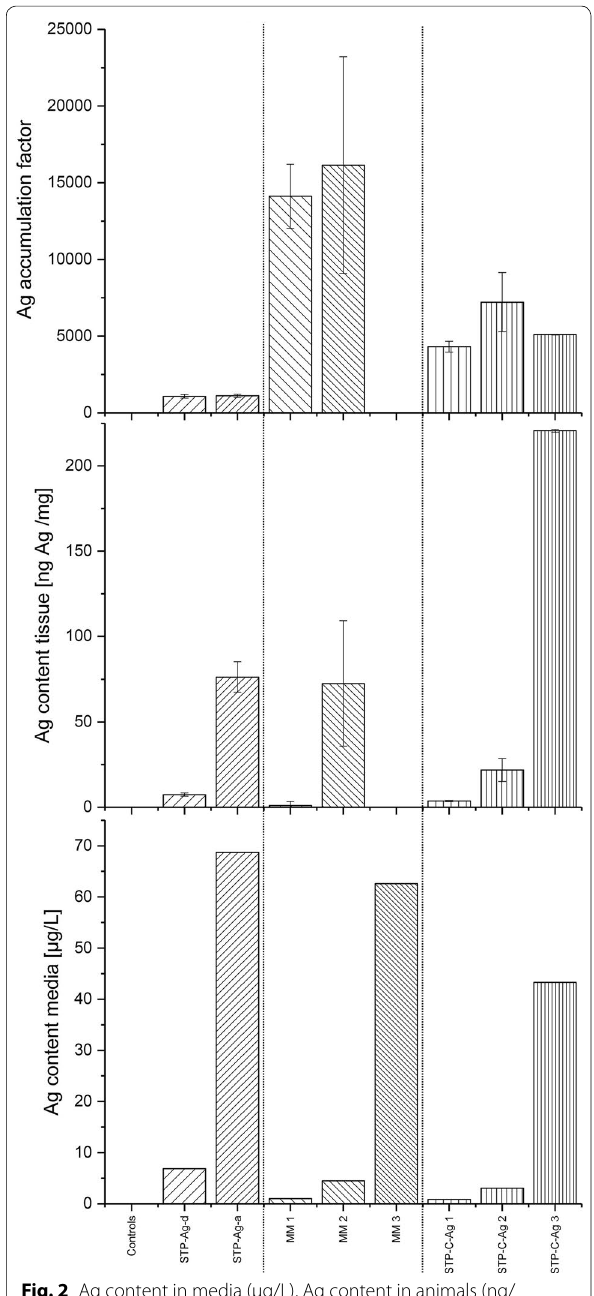
Fig. 2 Ag content in media (µg/L), Ag content in animals (ng/ mg) SD and accumulation of silver after 21 days of exposure. Ag ± accumulation factor concentration in Hyalella /concentration in test =